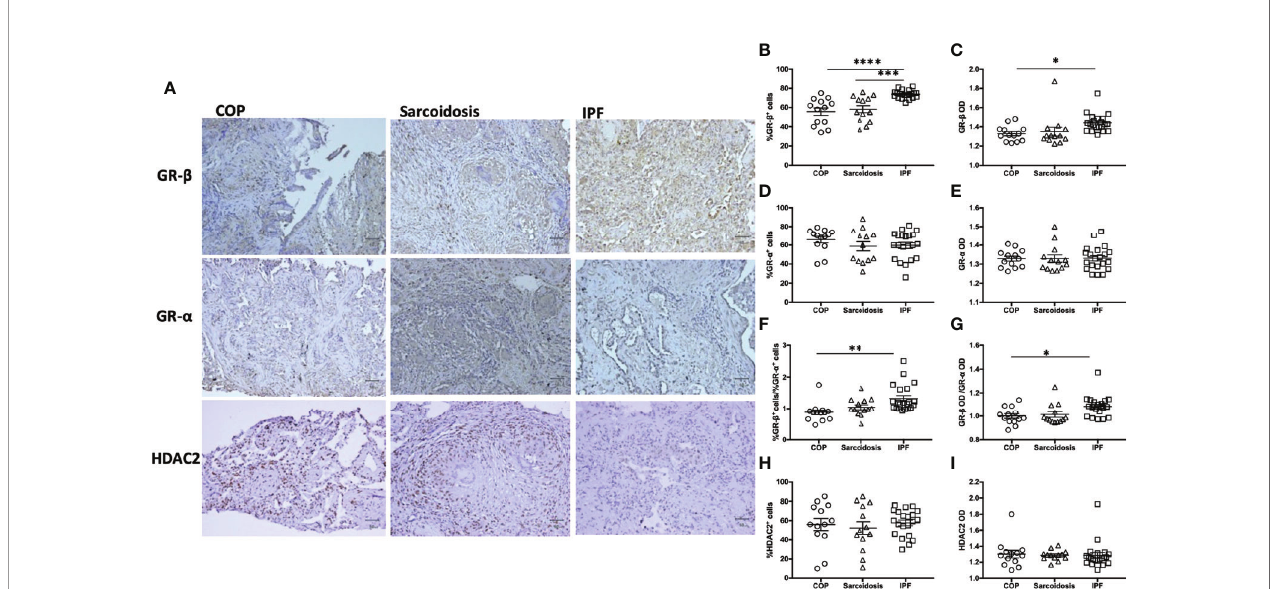
FIGURE 3 | Greater expression of GR- b in IPF. (A) Representative immunohistochemical stain images of lung specimens from subjects with COP, sarcoidosis and IPF. Magni fi cation X200. Proportion of positive staining cells (B, D, F, H) and OD (C, E, G, I) in lung specimens from subjects with ILDs (COP, sarcoidosis and IPF in combination), determined by both examiners and software-determined opacity density score. IPF patients had greater GR- b and GR- b /GR- a ratio. Horizontal lines represent the means ± SEM values for each group. GR, glucocorticoid receptor; IL-17, interleukin-17; IPF, idiopathic pulmonary fi brosis; COP, cryptogenic organizing pneumonia; OD, opacity density score; *p < 0.05; **p < 0.01, ***p < 0.001, ****p < 0.0001.